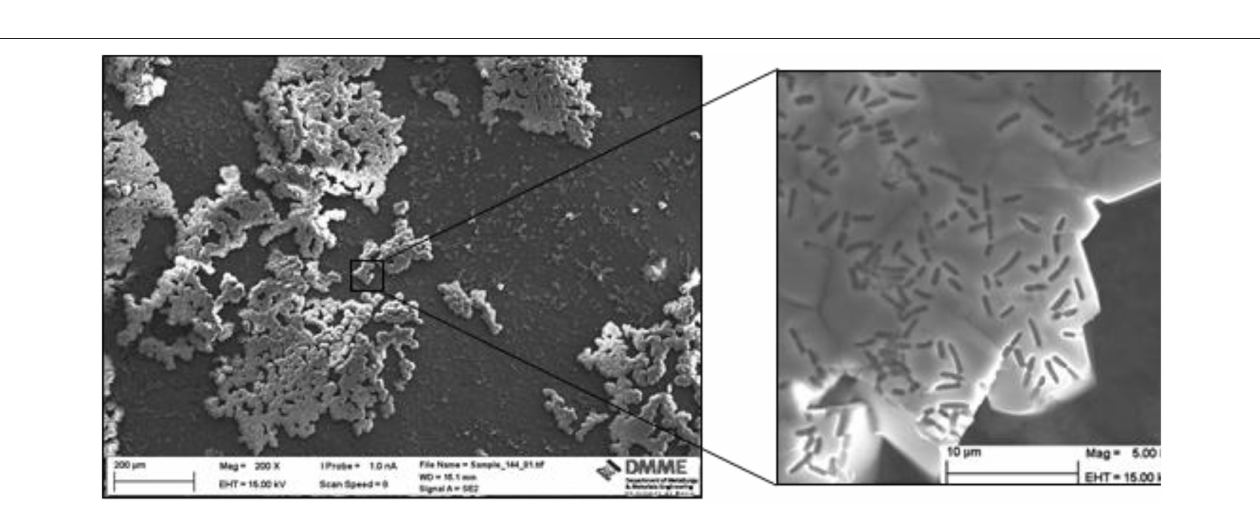
FIGURE 3 | FTIR spectra for scraping from surface of samples 1bAc7 (treated with L. sphaericus and Ca(CH3COO) 2 ), 1bCl7 (treated with L. sphaericus and CaCl 2 ), and spectra for samples of Ca(CH3COO) 2 and CaCl 2 .